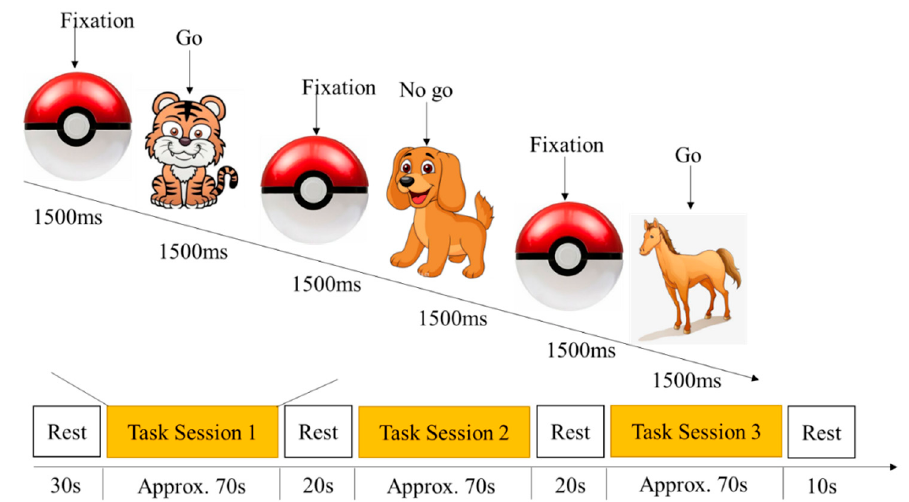
Figure 2. Task paradigm of Go/No-Go